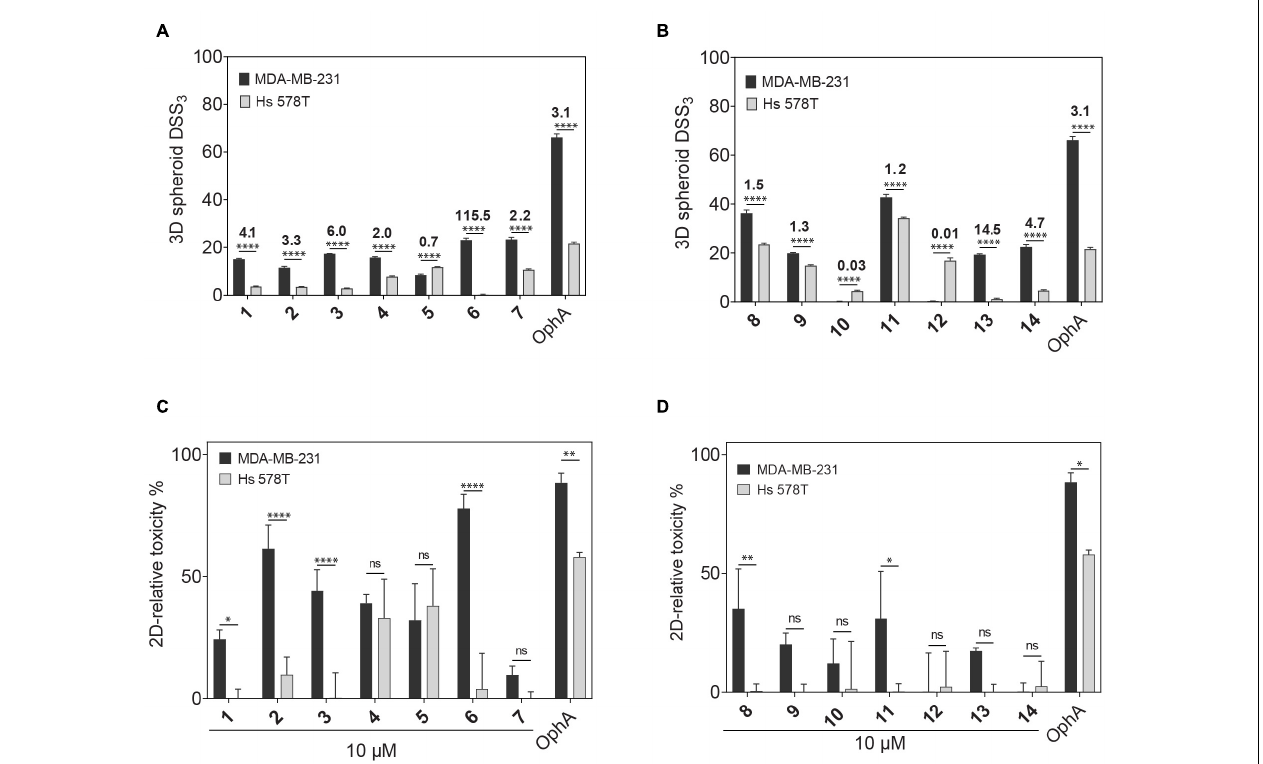
FIGURE 1 | Phenotypic assessment of anticlonogenic and cytotoxic activities of compounds. (A,B) A higher DSS 3 reflects a more potent effect of formyl aminobenzazulenones (A) and aminobenzazulenones (B) tested at a concentration range of 0.6–40 µ M on KRAS-mutant MDA-MB-231 and HRAS-mutant Hs 578T 3D spheroid formation in low attachment condition without serum. Data represent mean values ± SD, n ≥ 3. Numbers above the bars indicate the KRAS/HRAS mutant cell line DSS 3 ratios. (C,D) The relative toxicity of formyl aminobenzazulenones (C) and aminobenzazulenones (D) was assessed in the CellTox Green assay. Cells were grown as 2D adherent monolayers overnight and then treated for 72 h with 1 µ M OphA or 10 µ M of the indicated benzazulenones. Data represent mean values ± SD, n ≥ 2. The statistical significance levels are annotated as * p < 0.05; ** p < 0.01; **** p < 0.0001, or ns, not significant.